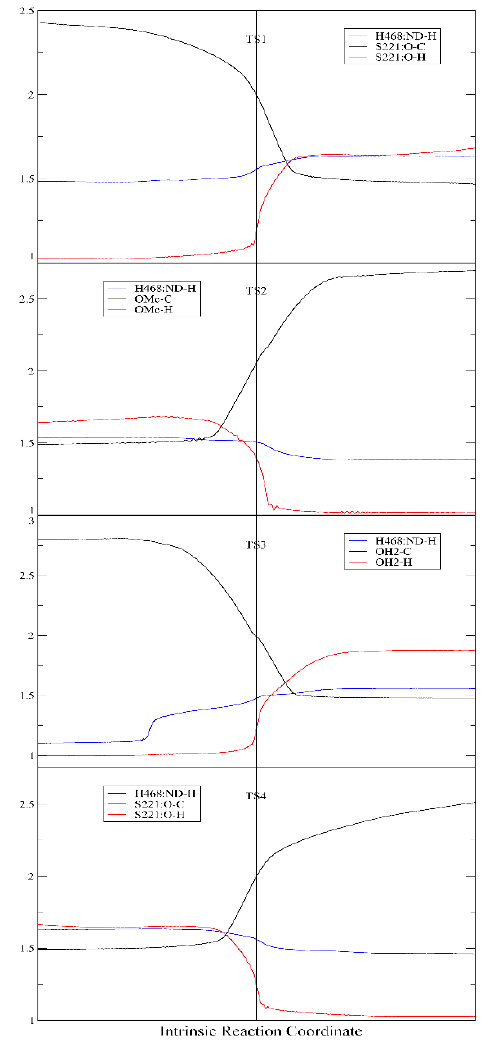
Figure 6. Distance (Å) of H468:N δ –H (Blue), oxygen atom of S221/methanol/water–H (Red), and oxygen atom of S221/methanol/water–carbonyl carbon atom (Black) along the intrinsic reaction atom of S221 / methanol / water–carbonyl carbon atom (Black) along the intrinsic reaction coordinate.